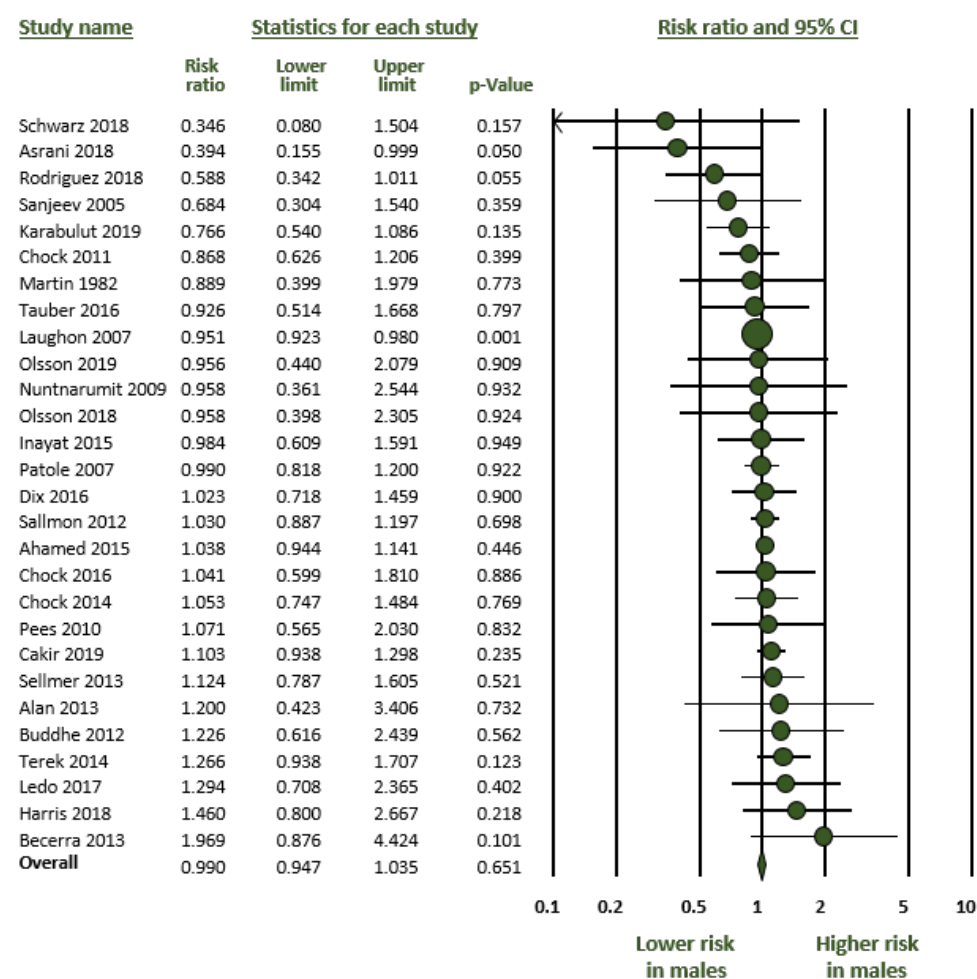
Figure 2. Meta-analysis on the association between sex of preterm newborns and risk of developing hemodynamically significant patent ductus arteriosus (hsPDA). Large ductal shunts were com- pared with small shunts plus closed DA. The median incidence of hsPDA in the cohorts was 36.7% (range 10.7 to 83.6%); CI: confidence interval; Risk ratio above 1 means higher risk in males.